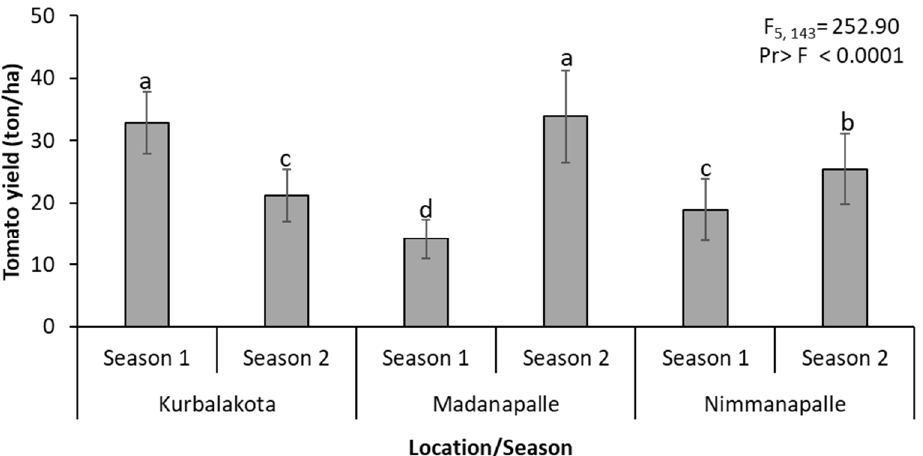
Figure 3. Mean ( ± SE) tomato yield in three different locations of Andhra Pradesh, India and two Figure 3. Mean (±SE) tomato yield in three different locations of Andhra Pradesh, India and two growing seasons (May–August 2018, September–December 2018). Means represent average of three growing seasons (May – August 2018, September – December 2018). Means represent average of three replications and eight treatments ( n = 24) in each location. Mean(s) followed by same letter(s) are not replications and eight treatments ( n = 24) in each location. significantly different based on Tukey’s HSD ( p =